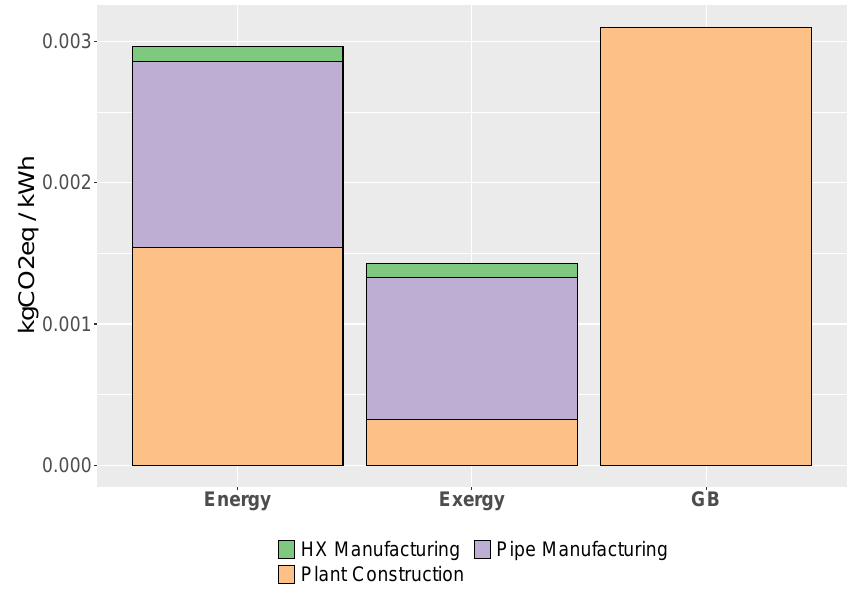
Figure 3. Specific emissions for DH with allocation methods and for GB-Detail of minor